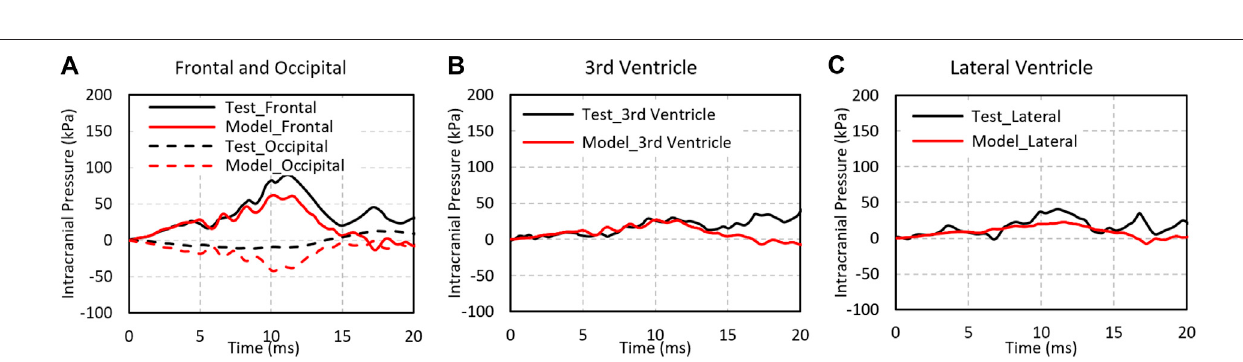
FIGURE5| Thepressurecomparison oftestand simulation dataforTest No.MS428_2. (A) Intracranialpressure atthefontal andoccipitalregions; (B) intracranial pressure at the third ventricle; (C) intracranial pressure at the lateral ventricle.